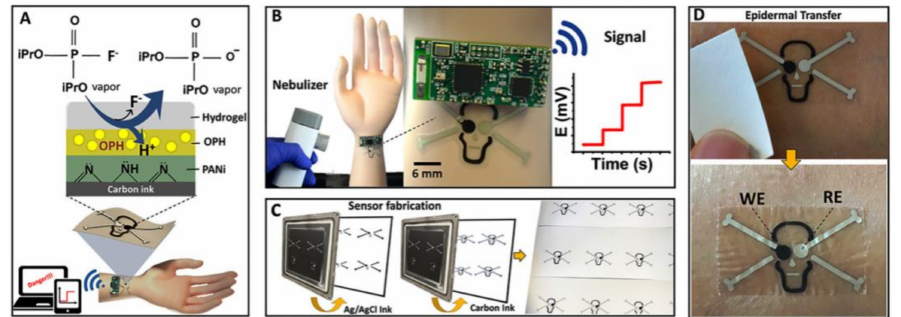
Figure 9. Diagrammatic representation of the tattoo-shaped potentiometric biosensor. ( A ) The concept of the biosensor. ( B ) Designing of the tattoo biosensor. ( C ) The printing process of the biosensor on paper. ( D ) Successful transfer and removal of the tattoo on human skin. Reproduced from Reference [87] with permission. Copyright 2018, Elsevier.